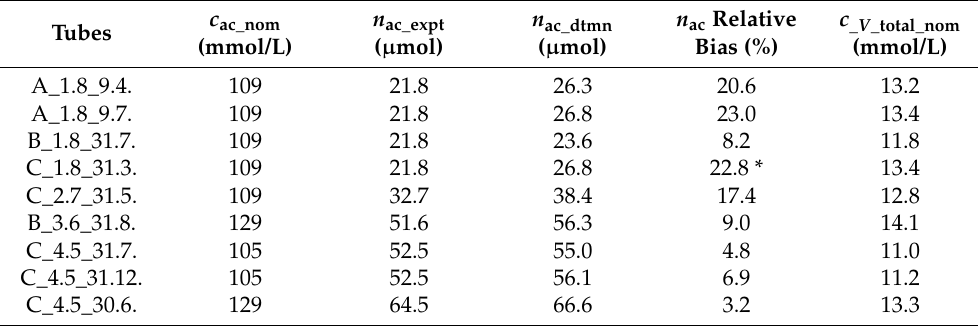
Table 5. Results of citrate determination in composite samples prepared from the blood collec- tion tubes with Milli-Q water and expressed as an anticoagulant amount per tube ( n ac_dtmn ) and the expected anticoagulant concentration ( c _ V _total_nom ) if the nominal draw-volume and nominal anticoagulant volume are both compliant with the values declared by the